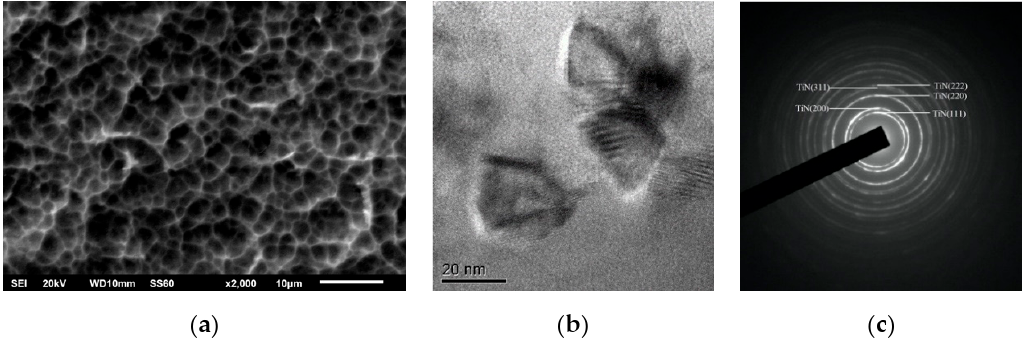
Figure 2. SEM images of surface, ( a ) high-resolution electron microscopic images of the coating structure, ( b ) and TEM patterns ( c ) of the Ti–Al–Ni–N coatings.